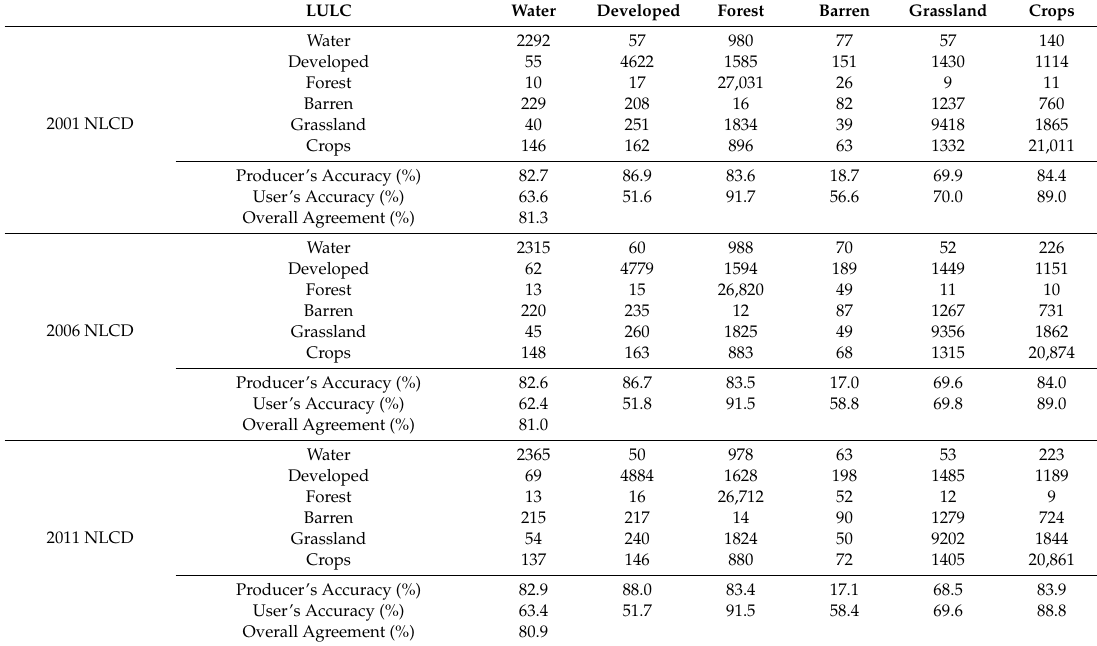
Table 3. St. Louis footprint confusion matrix contrasting agreement between the three NLCD validation datasets. Overall agreement was consistently ~81%. Note that units are counts of 30 × 30 m pixels, except Producer’s and User’s Accuracy and Overall Agreement, which are